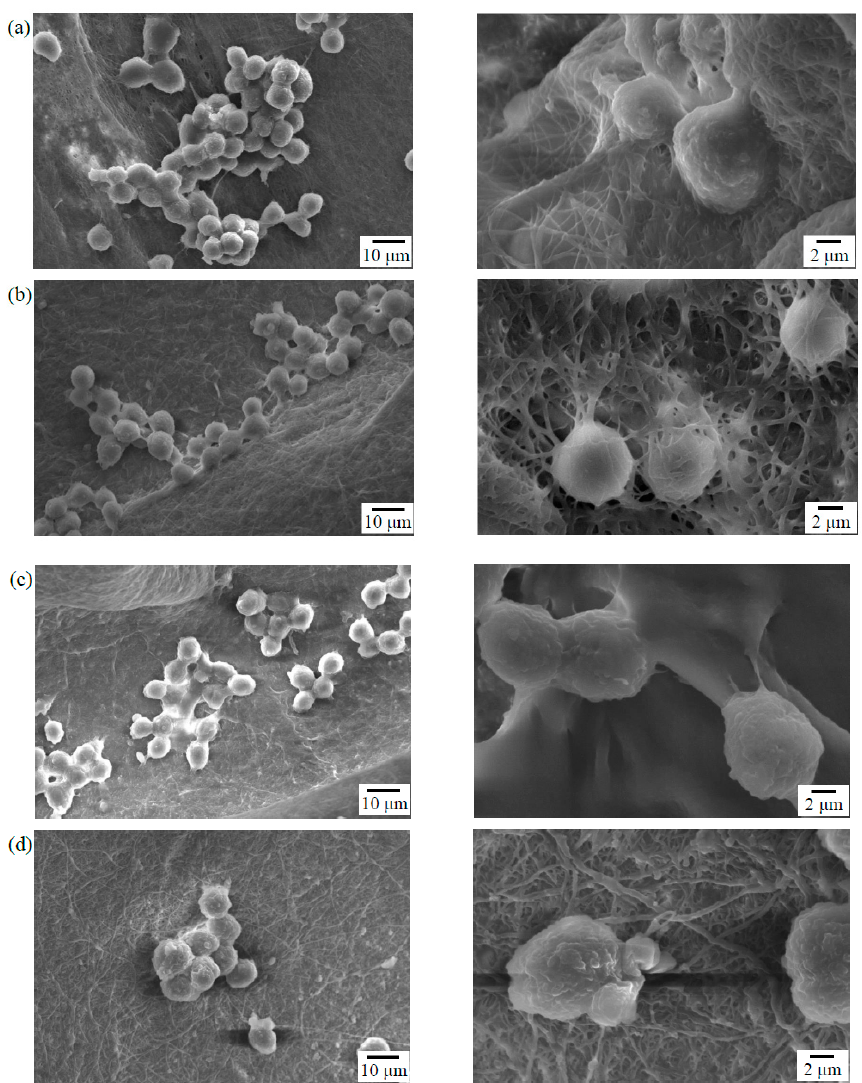
Figure 6. SEM photographs of the MG-63 cells that adhered to the surfaces of the γ –PGA/ β –TCP composite fibrous mats with different γ –PGA/ β –TCP weight ratios and different cystamine treatment times: ( a ) 20:1, 12 h; ( b ) 20:1, 24 h; ( c ) 40:1, 12 h; and ( d ) 40:1, 24 h after 6 h of culture.